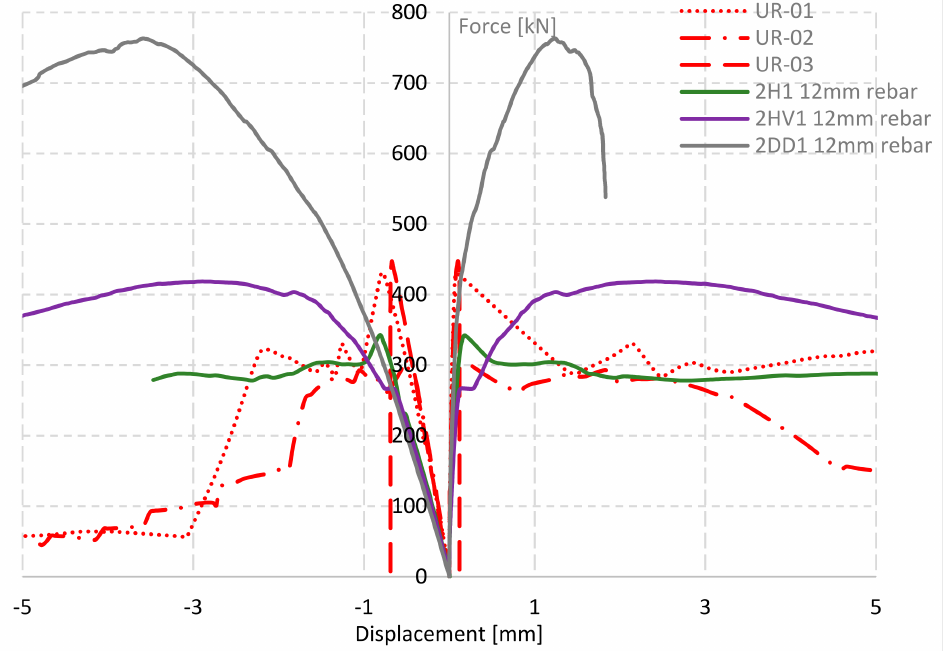
Figure 16. Force-displacement of SB reinforced vs. UR